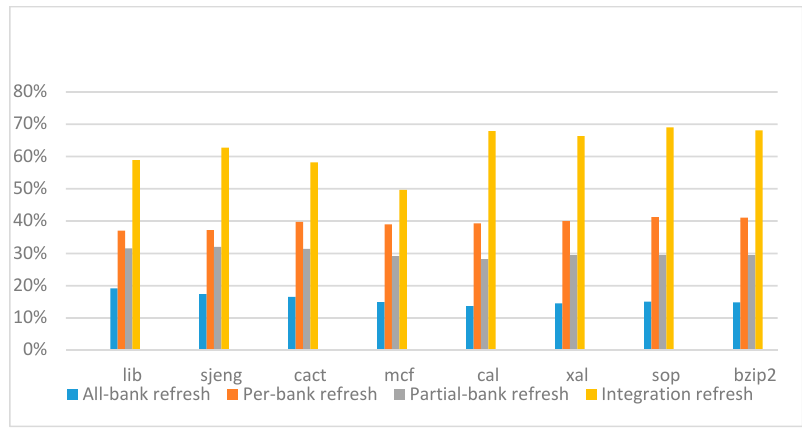
Figure 27. Energy reduction normalized to 1x granularity baseline (tRFC = 890 ns, weak row = 2%).